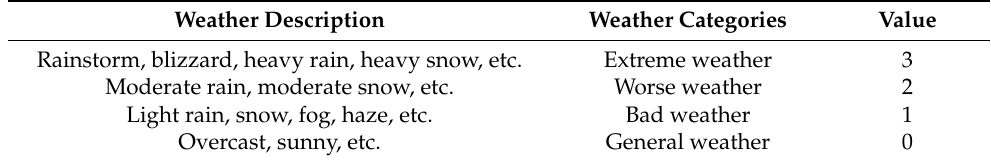
Table 2. The values of weather features. Weather